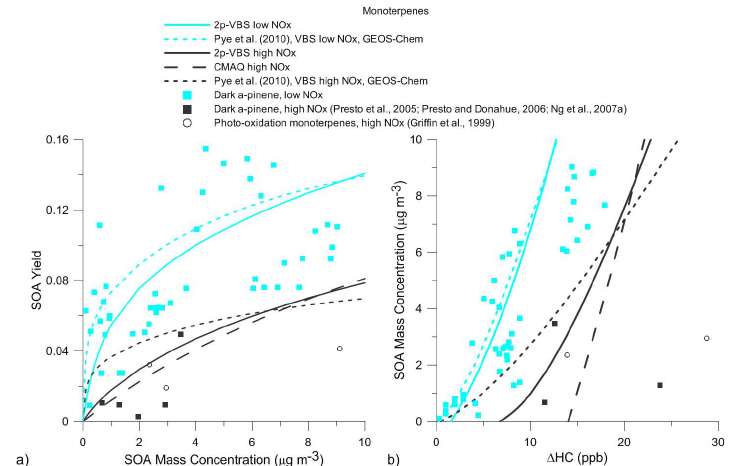
Fig. 3. Evaluation of 2p and 2p-VBS parameterizations for lumped monoterpenes under low-NO x (cyan) and high-NO x (black) conditions. (a) Theoretical yield curve (SOA yield vs. SOA mass concentration); (b) predicted SOA mass curve (SOA mass concentration vs. level of reacted hydrocarbon, 1